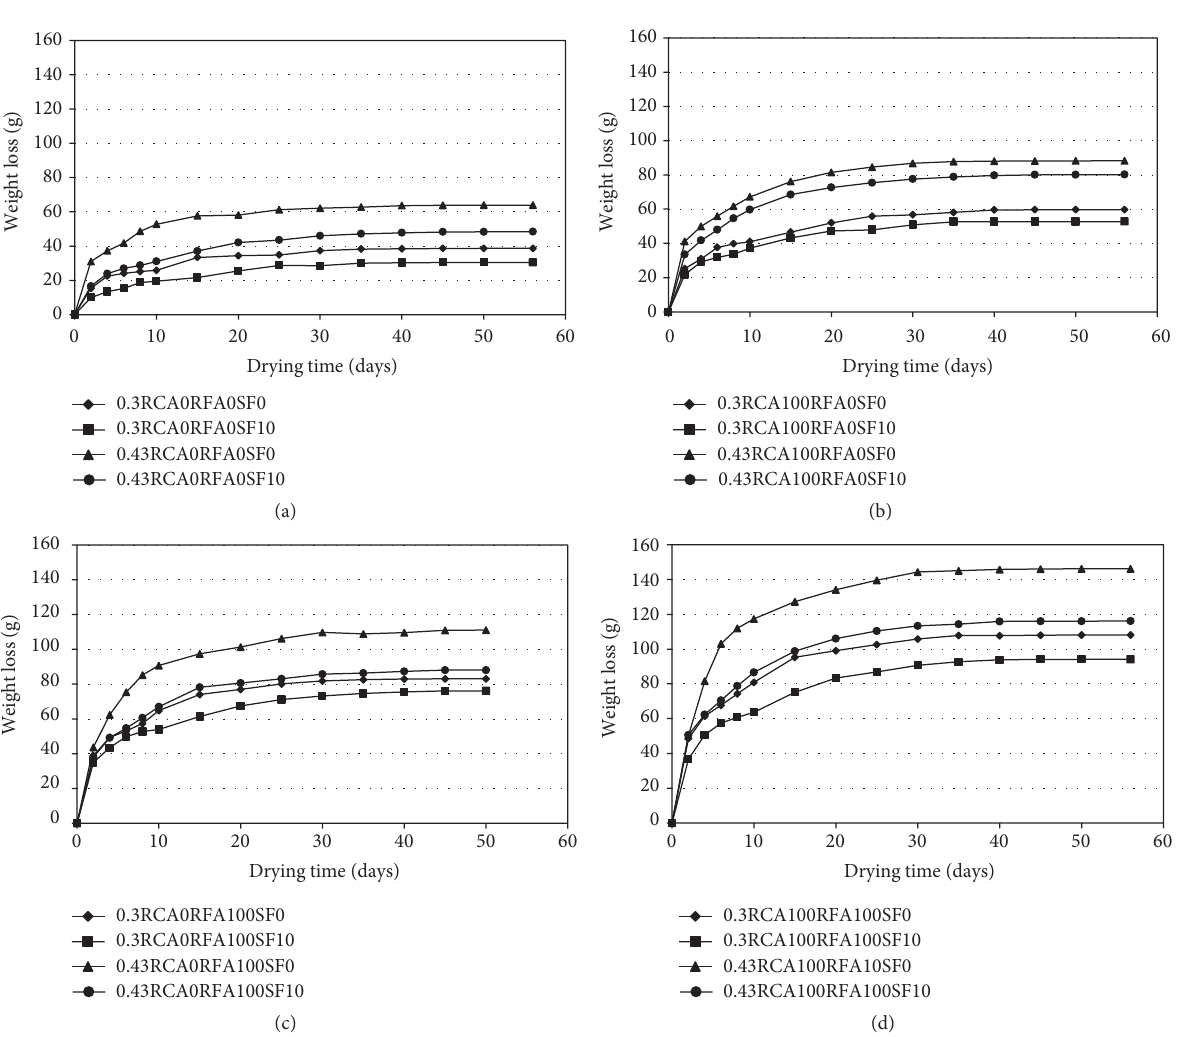
Figure 13: Weight loss for SCCs according to type of aggregate: (a) NAs (Series I), (b) RCA (Series II), (c) RFA (Series III), and (d) RAs (Series